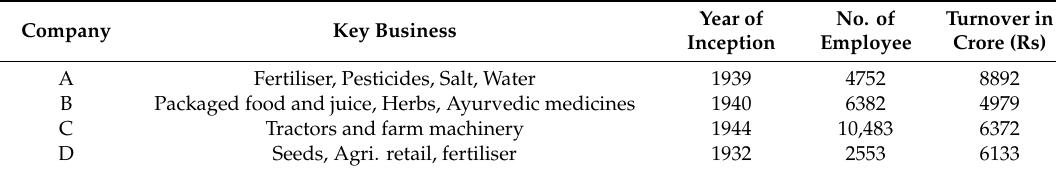
Table 1. Profile of sample